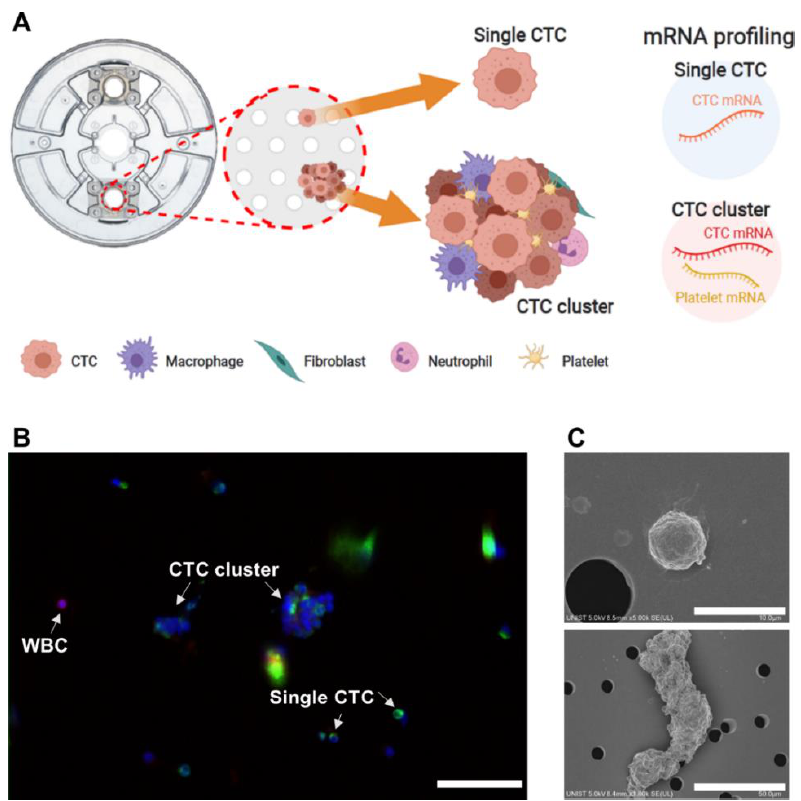
Figure 1. Scheme of circulating tumor cell (CTC) characterization. ( A ) Scheme of CTC characteri- zation using mRNA profiling. ( B ) Immunofluorescence image of CTCs and white blood cell (WBC) (scale bar: 50 µm). ( C ) Scanning electron microscope images of single CTC and CTC clus- ter.